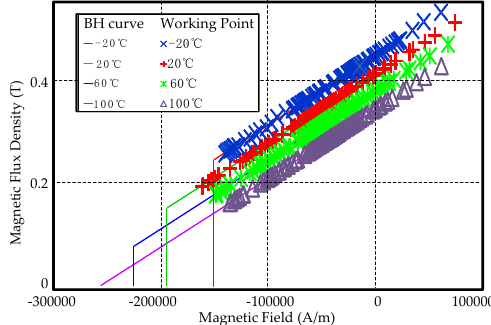
Figure 13. The working points of measuring point C 1 .